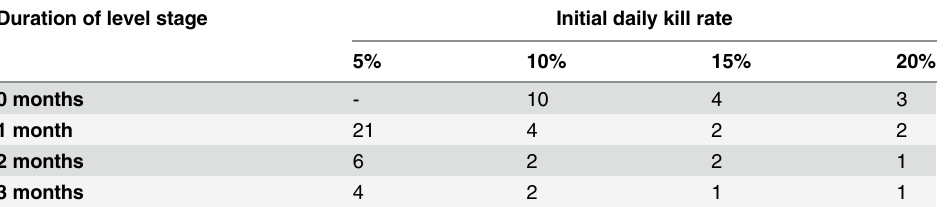
Number of years required for local elimination of an isolated tsetse population using kill rates of 5 – 20% at the start of each year, with different durations of the level stage of target ef fi cacy, and with the declining stage set at three months. In the level stage the ef fi cacy of each target is at its maximum each day. In the declining stage the daily ef fi cacy of the targets declines linearly to zero. Where "-" is shown the population could not be eliminated in any number of